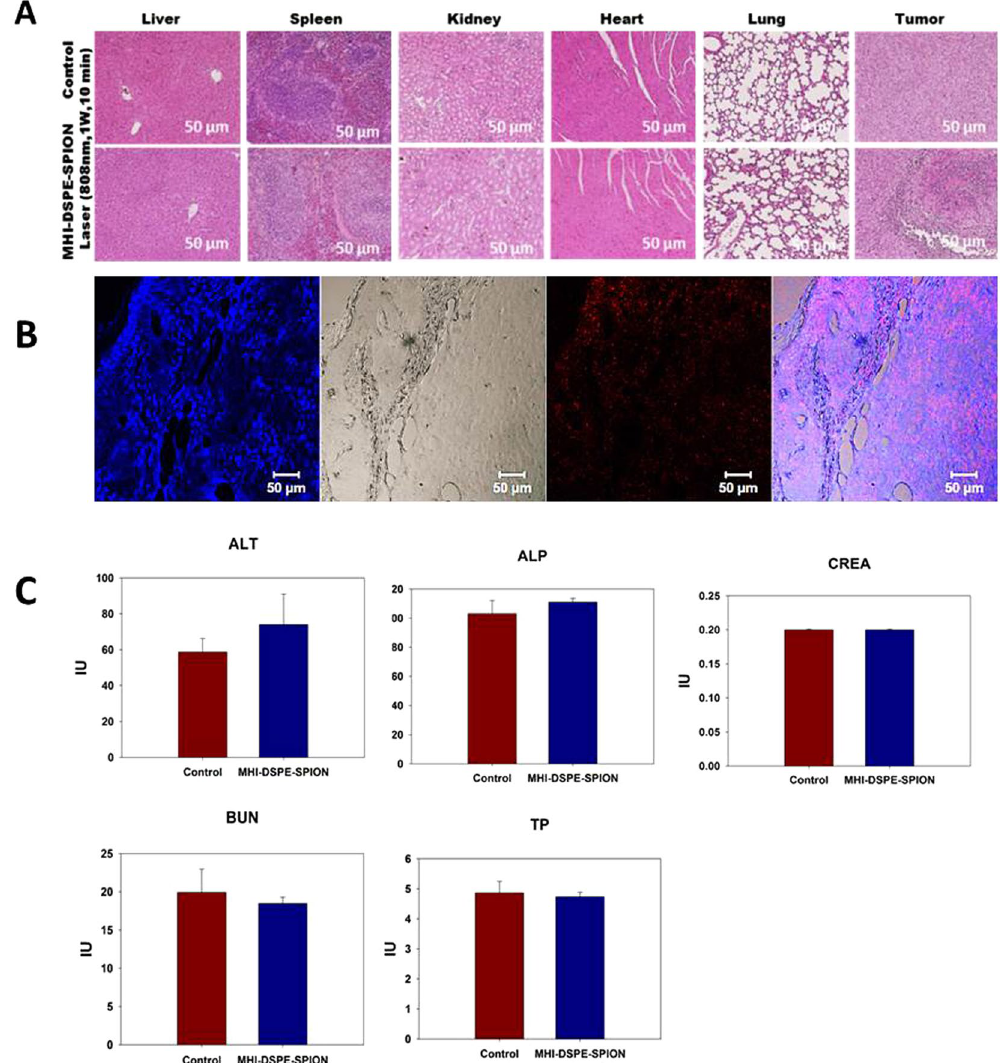
Figure 12. Histological assessment and blood biochemistry analysis of MHI-DSPE-SPION. ( A ) HE stain of five organ tissues (liver, spleen, kidneys, heart and lung) and tumor from the mice treated with MHI-DSPE- SPION, 24 hrs after PTT treatment. ( B ) Confocal fluorescent microscopic analysis of tumor tissue after PTT. Red fluorescence, signifying the presence of MHI-148 in tissue. ( C ) Blood biochemical analysis of alanine aminotransferase (ALT), alkaline phosphatase (ALP), creatinine (CREA), blood urea nitrogen (BUN) and total protein (TP) in BALB/c mice (n = 4). The cardiac puncture method was employed to collect 1 mL of fresh blood from